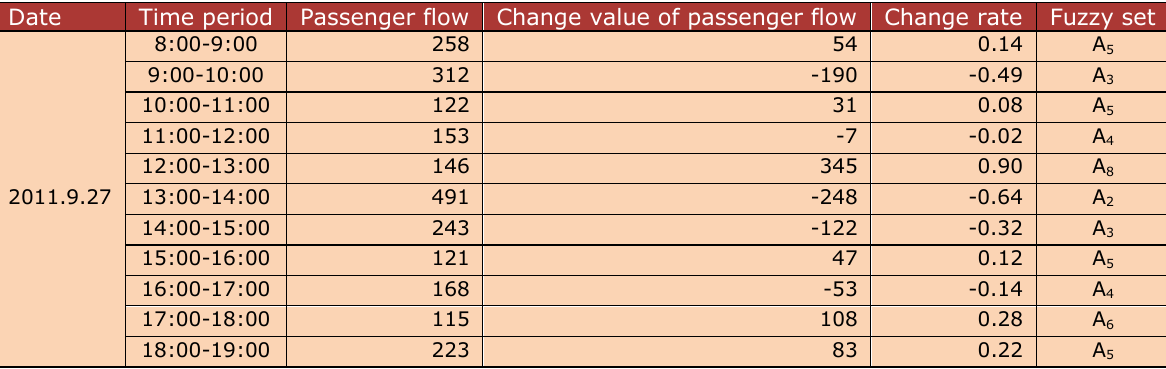
Table 1. Information of passenger flow